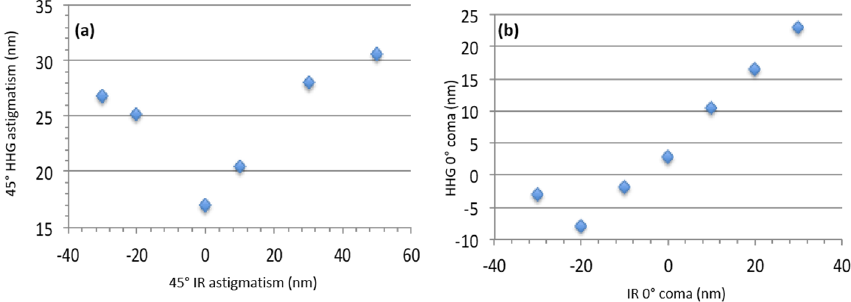
Figure 10. Variation of the HHG wavefront versus the IR driving laser wavefront considering pure 45° astigmatism ( a ) and pure 0° coma ( b ).